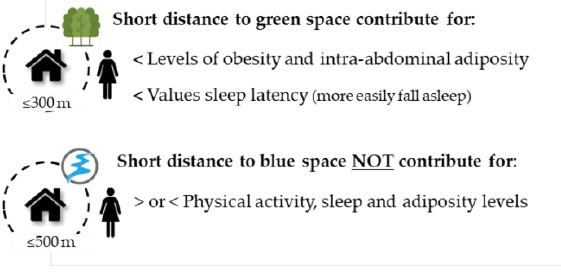
Figure 5. Main results of study.